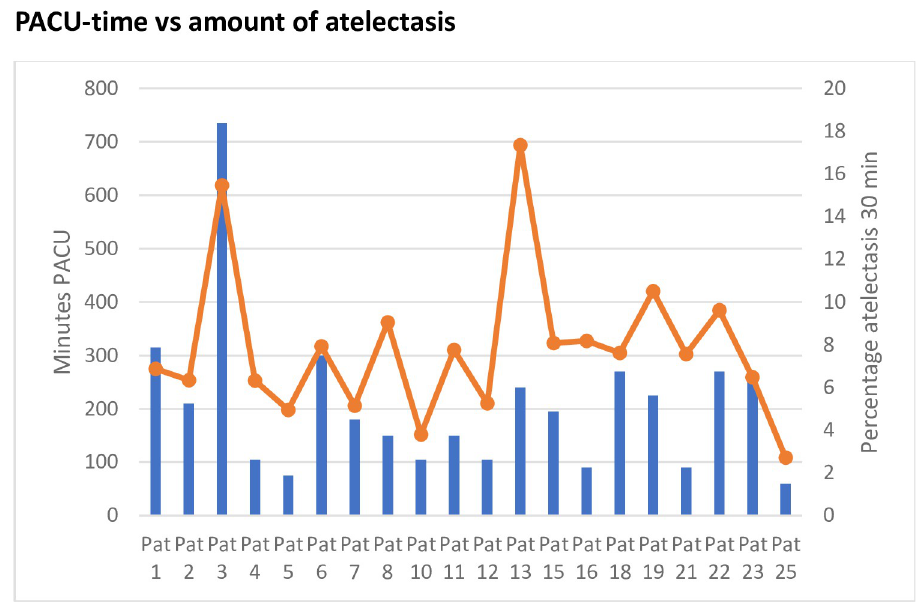
Fig 5. Time spent in the post anaesthesia care unit (minutes, left y-axis) and the amount of atelectasis at time 30 minutes (percentage, right y-axis) after start of HFJV (high frequency jet ventilation). Blue bars represent minutes in the PACU and orange dots represents amount of